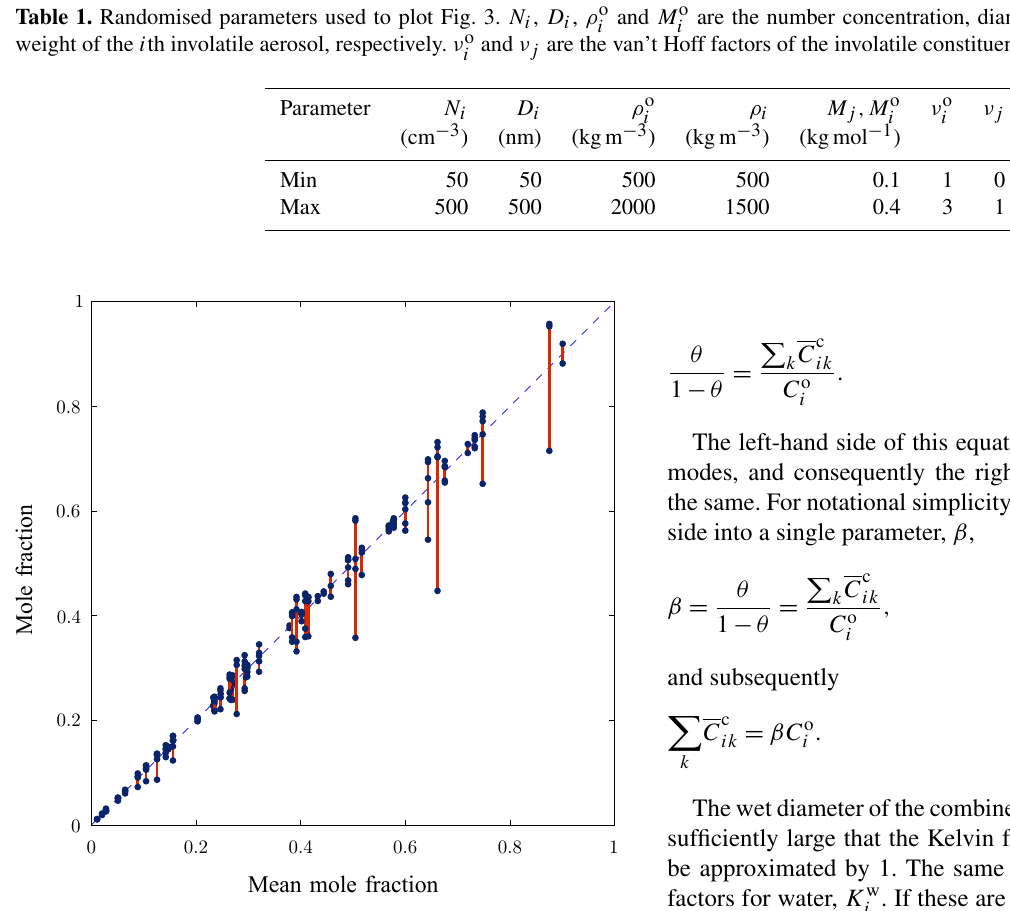
Figure 3. The mole fractions of multiple different involatile aerosol modes plotted against the mean mole fraction on the x axis. Fifty solutions are shown with parameters randomly chosen from the ranges shown in Table 1 with RH = 0%. The volatility distribution of SVOCs is shown in Table 2, but is rescaled by a random factor of between 0 and